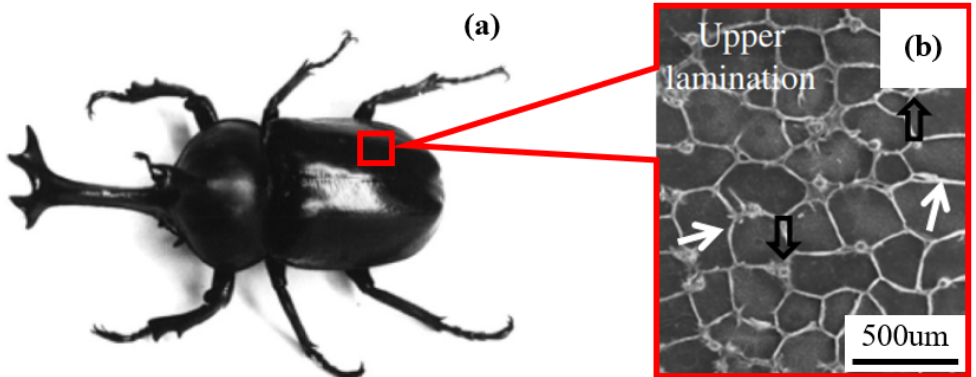
Figure 1. BHTS and its application: ( a ) the beetle Allomyrina dichotoma ; ( b ) micromorphology of the honeycomb structure with columns [22] Copyright©5430520399371.